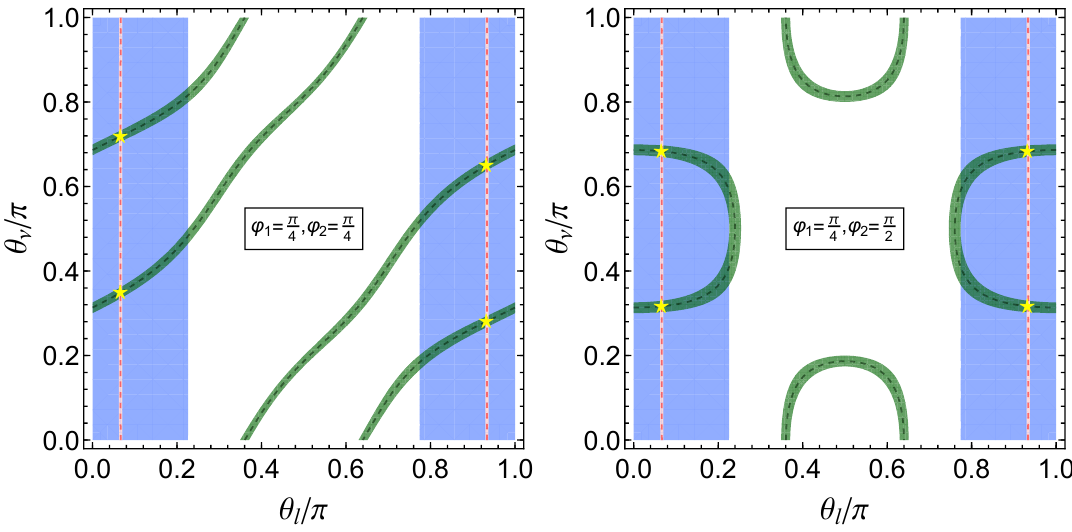
Figure 1 . Contour plots of sin 2 (cid:18) ij in the (cid:18) (cid:23) (cid:0) (cid:18) l plane for mixing matrix U I ; 6 with n = 4. The panels in the left and right sides are for ( ’ 1 ; ’ 2 ) = ( (cid:25)= 4 ; (cid:25)= 4) and ( (cid:25)= 4 ; (cid:25)= 2) respectively. The red, green and blue areas denote the 3 (cid:27) contour regions of sin 2 (cid:18) 13 , sin 2 (cid:18) 12 and sin 2 (cid:18) 23 respectively. The dashed contour lines represent the corresponding experimental best (cid:12)t values. The 3 (cid:27) ranges as well as the best (cid:12)t values of the mixing angles are adapted from [8]. The best (cid:12)tting values of (cid:18) l;(cid:23) are indicated with yellow